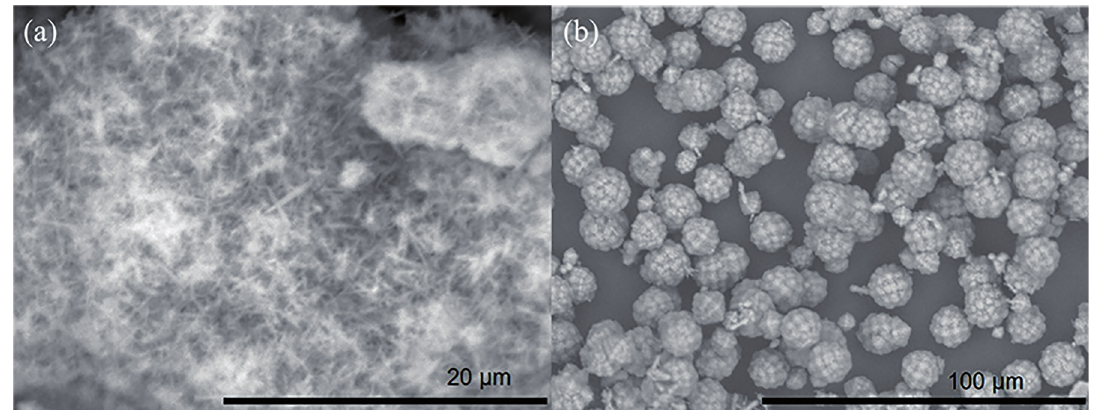
Figure 10: SEM images of samples obtained with ionic liquid by method B - (a) 3 days in stirring (TON) and (b) 3 days in static